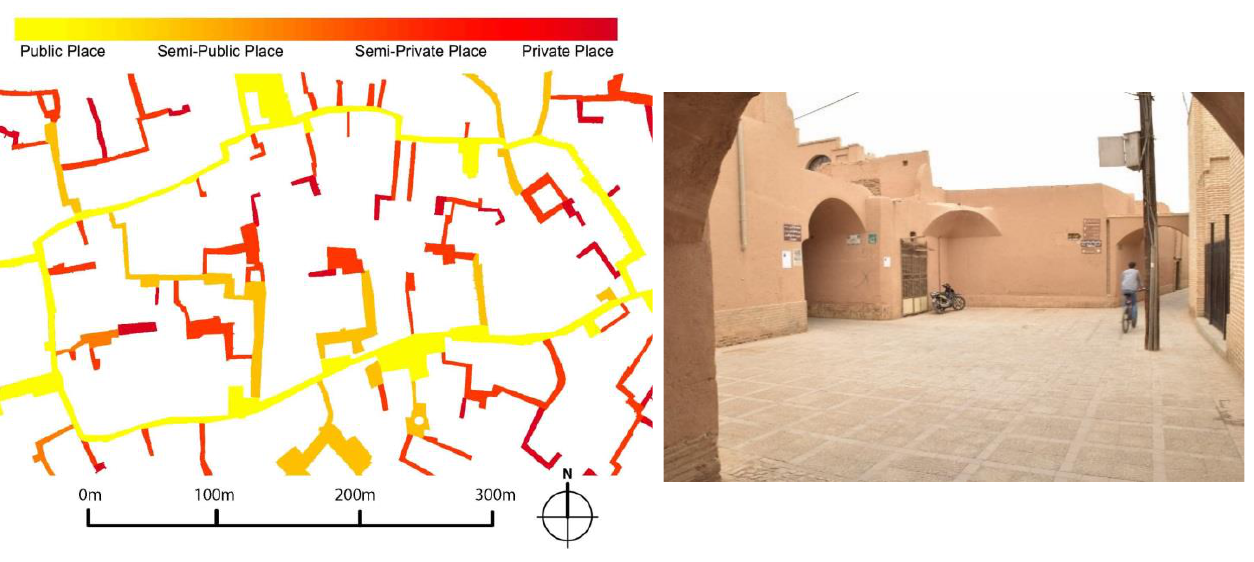
Figure 3. Hierarchical in-between spaces and the formation of spatial liminality in historic Kashan [31].